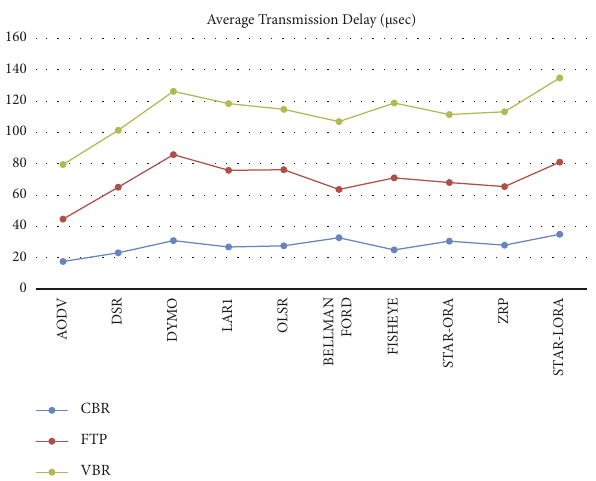
Figure 35: Average jitter of all routing protocols in CBR, FTP, and VBR